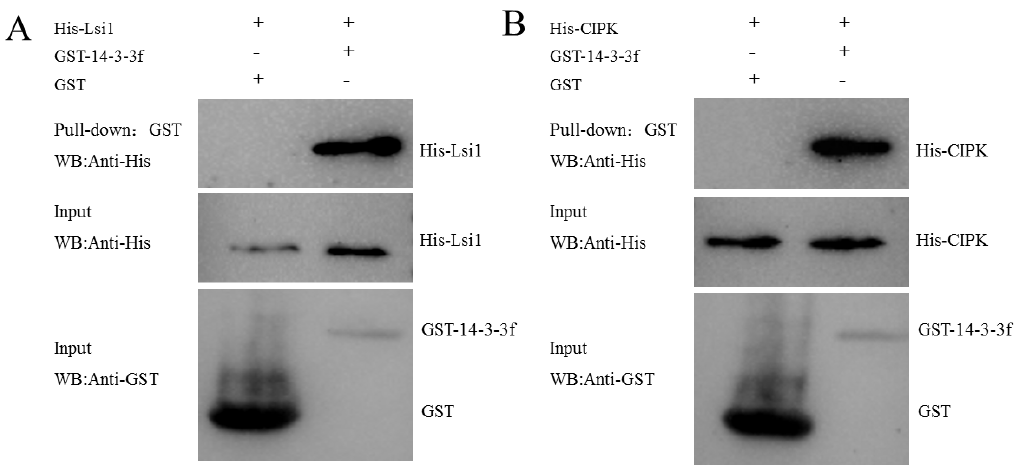
Figure 10. Confirmed protein interaction proteins via Western blot. ( A ) The interaction between the Lsi1 and 14-3-3f. ( B ) The interaction between the 14-3-3f and CIPK.